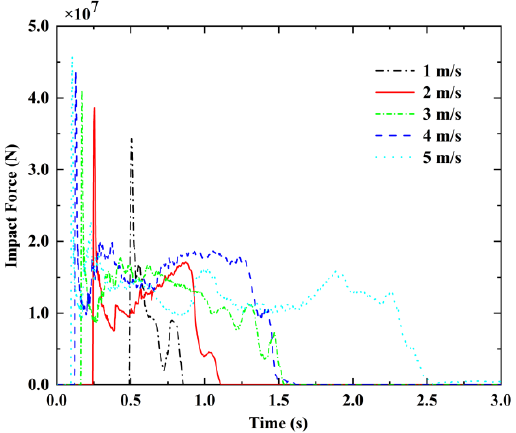
Figure 10. Comparison of impact forces at different impact velocities.